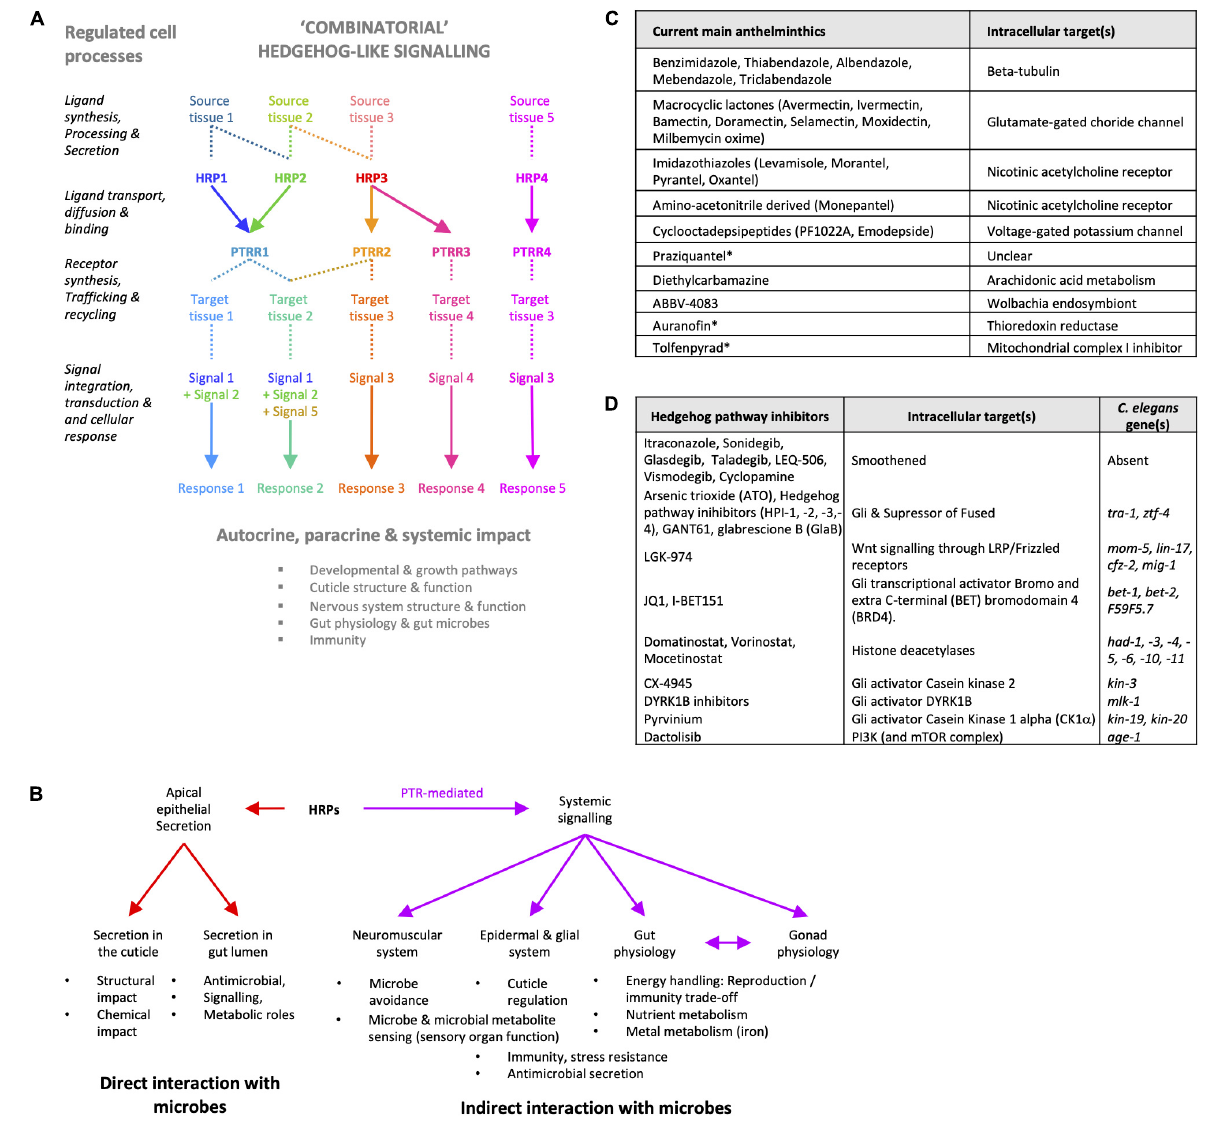
FIGURE 5 | Targeting Hedgehog-like signaling to disrupt nematode-microbe interactions. (A) Hedgehog-like signaling (HHLS) involves multiple regulated steps with druggable targets (ligand processing/maturing enzymes, transporters, receptors and co-receptors, regulators of membrane trafficking and recycling) and regulates multiple aspects of nematode physiology (growth, development, immune and structural defenses, nervous system, and gut functions). Based on paralog sequence similarities, overlaps in tissue expression, and transcriptomics data, nematode HHLS may rely on partially redundant and/or combinatorial signaling, to be elucidated. (B) Whether and how nematode Hedgehog-related peptides (HRPs) may directly or indirectly interact with microbes also remain to be clearly established. (C) The main anthelminthic strategies currently in use or being explored ∗ mostly target the nematode neuromuscular system and do not intersect with HHLS (Elfawal et al., 2019; Hahnel et al., 2020; Partridge et al., 2020). (D) Main Hedgehog signaling inhibitors used in oncology either target the less conserved part of the HH pathway (Smoothened and Gli), Wnt signaling, or conserved but low-specificity activators of HH pathway genes (Peer et al., 2019; Jamieson et al., 2020). HH, Hedgehog; HRP, Hedgehog-related peptide; PTRR, Patched-related